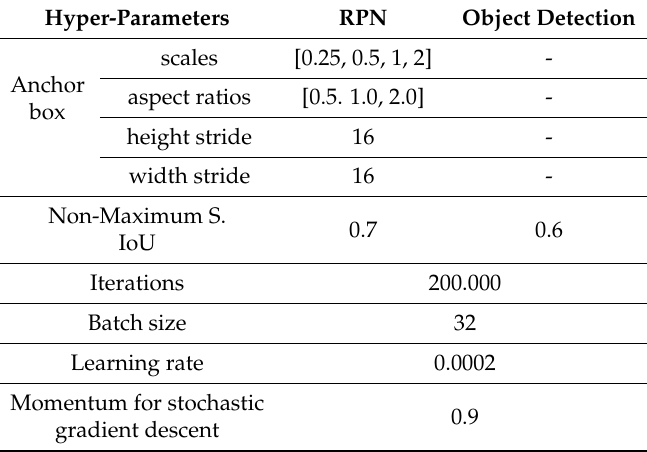
Figure 4. Faster R-CNN object detection with Inception V2 meta-architecture. The output depicts the input image plus the bounding boxes around cherries. Table 1. Faster R-CNN